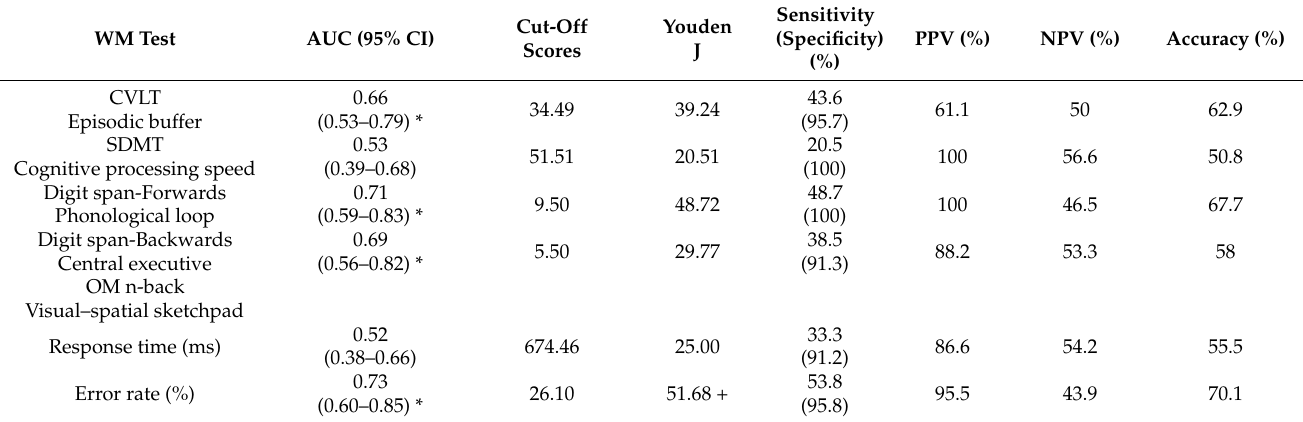
Table 2. Diagnostic accuracy of WM tests.